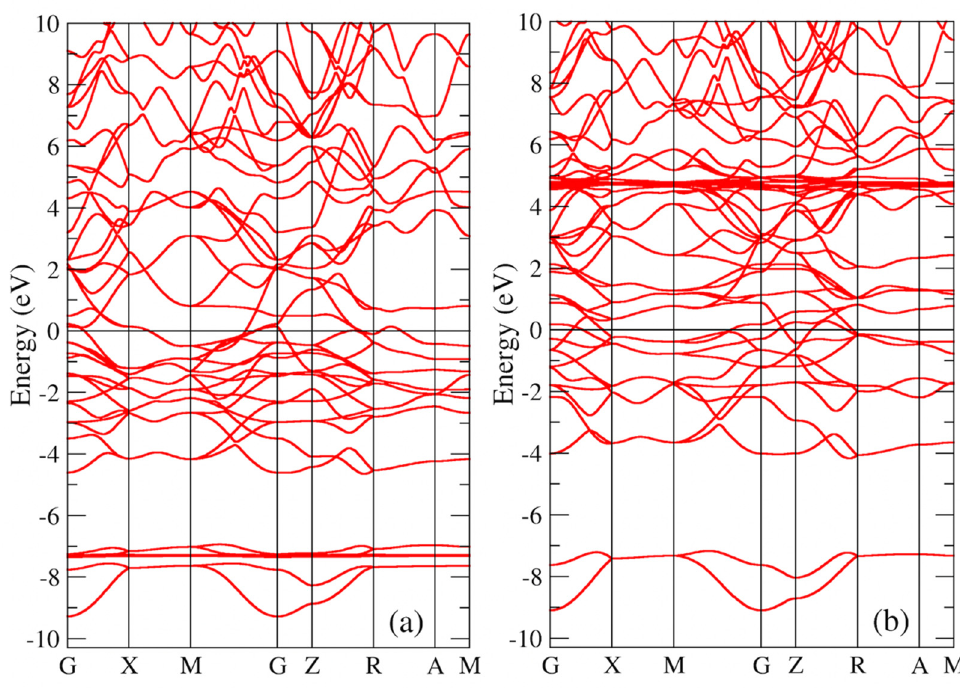
Figure 4. Band structure of GdMnSi. ( a ) Majority spin projection; ( b ) minority spin projection. The Fermi level is a solid horizontal